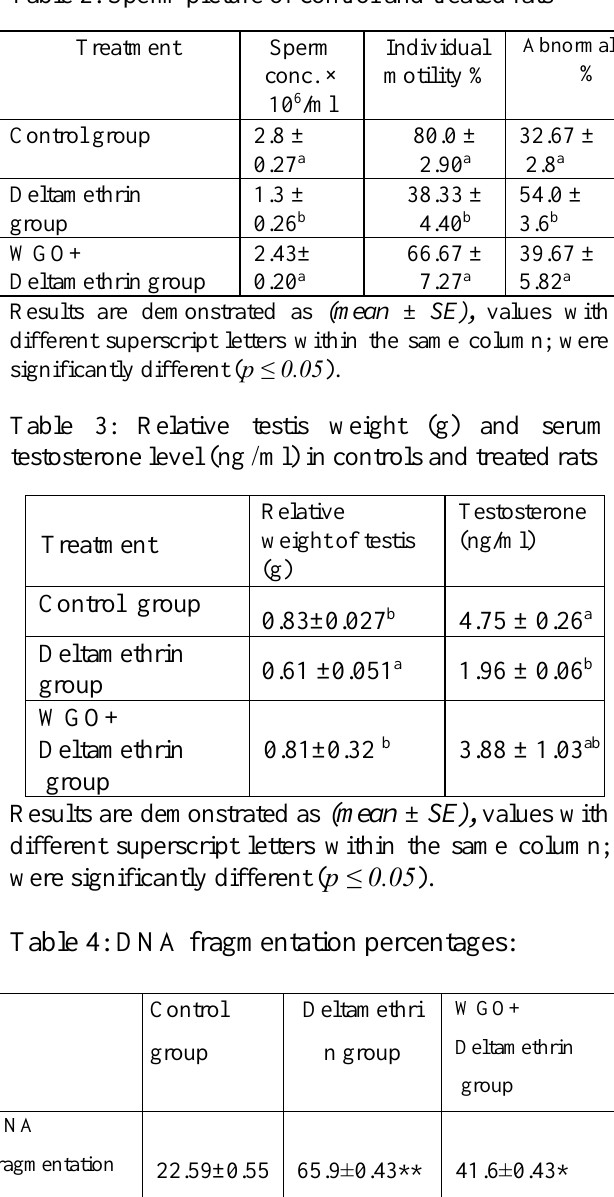
Results are demonstrated as (mean ± SE) * Superscript means significant differences versus control at P≤0.05. ** Superscript means significant differences versus control at p ≤ 0.01 .